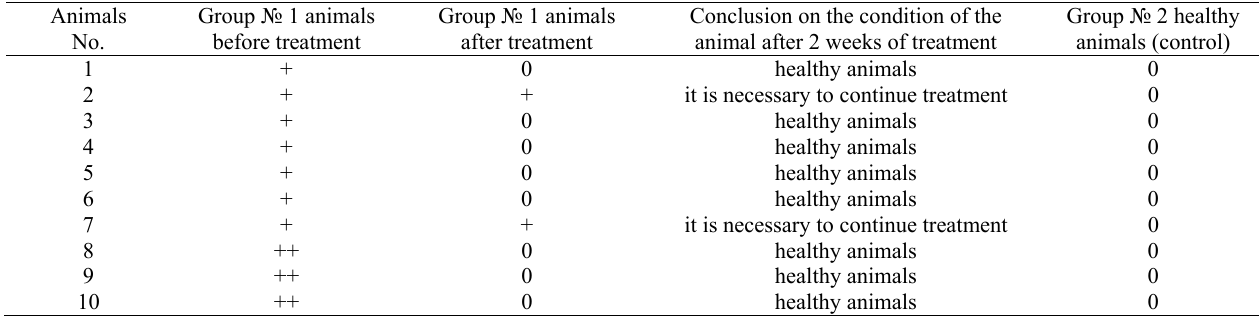
The presence and intensity of the inflammatory process of the German Shepherd dogs